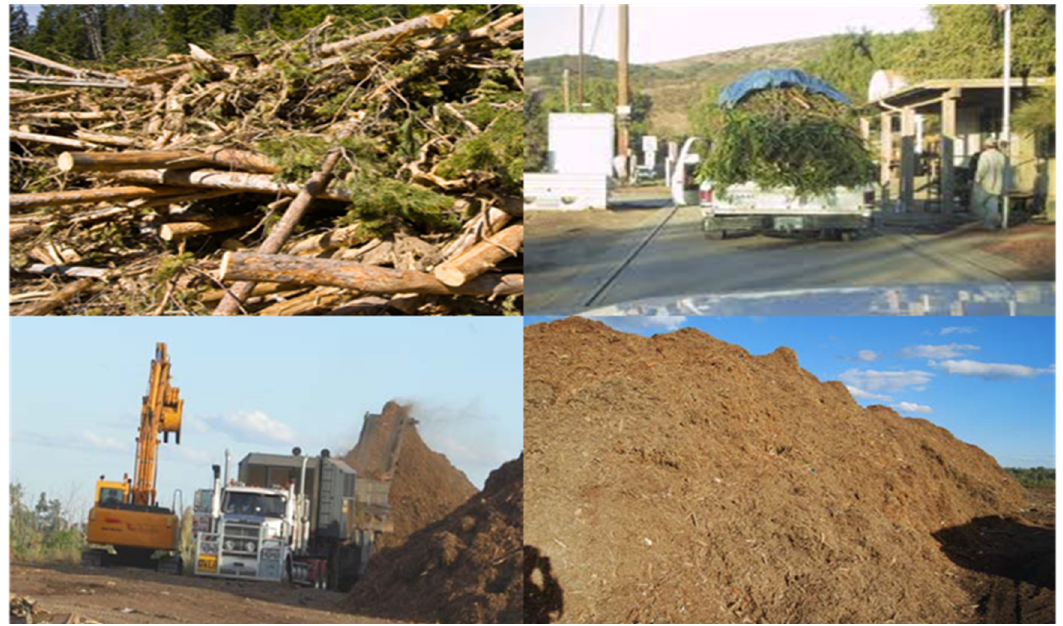
Figure 1. MGW ( top left ); MGW collection ( top right ); portable tub grinder used to shred MGW ( bottom left ); and stockpiled shredded MGW ( bottom right